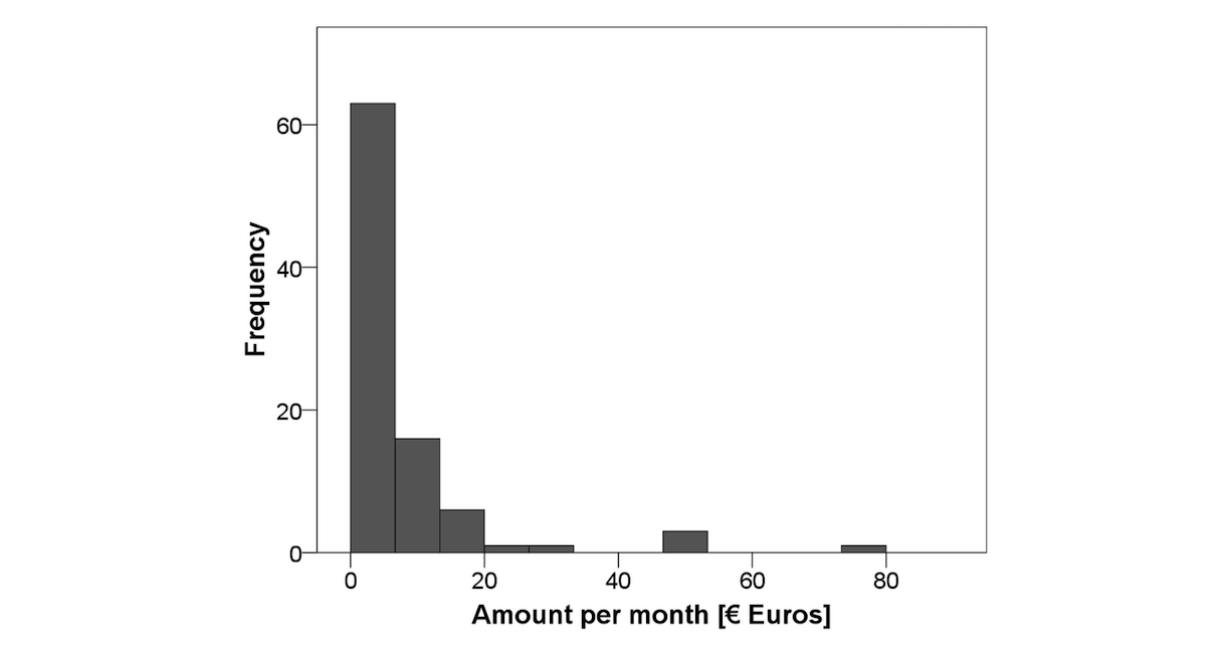
Figure 2. Histogram for the willingness to